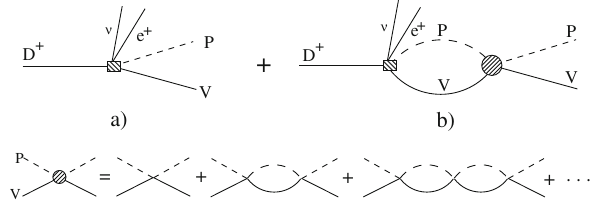
Fig. 2 V P final state